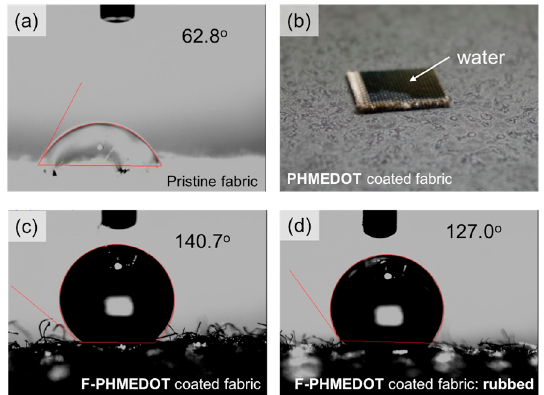
Figure 2. ( a ) Apparent water contact angle of a pristine, tight-woven, raw cotton fabric. ( b ) Photograph of a tight-woven, raw cotton fabric after vapor coating with PHEMDOT, showing the extreme hydrophilicity of the fabric surface. A water droplet placed on this coated fabric surface is immediately absorbed into the fabric. ( c , d ) Apparent water contact angles of ( c ) a tight-woven cotton fabric after vapor coating with F-PHMEDOT, and ( d ) the same vapor-coated fabric after mechanical rubbing.